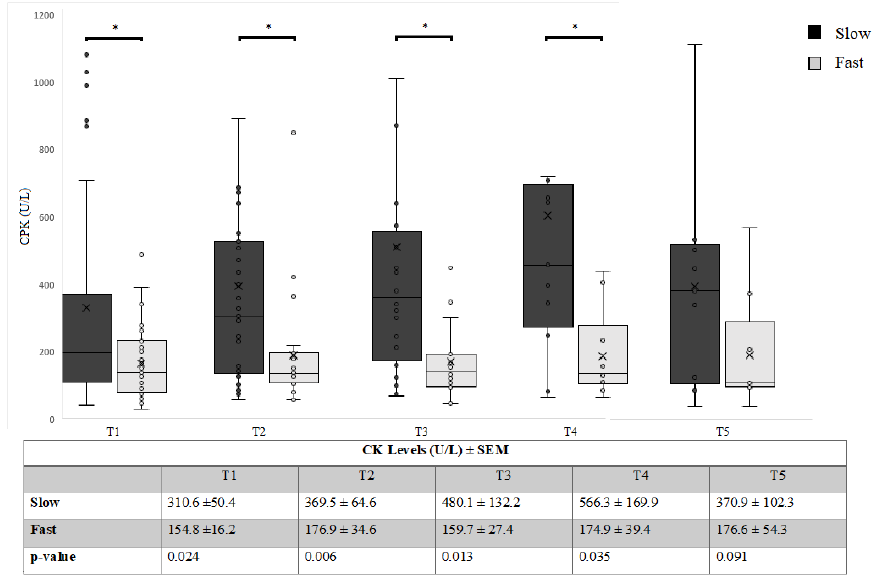
Figure 1. Mean CK levels (U / L) in slow vs. fast progressive ALS patients. * p < 0.05.